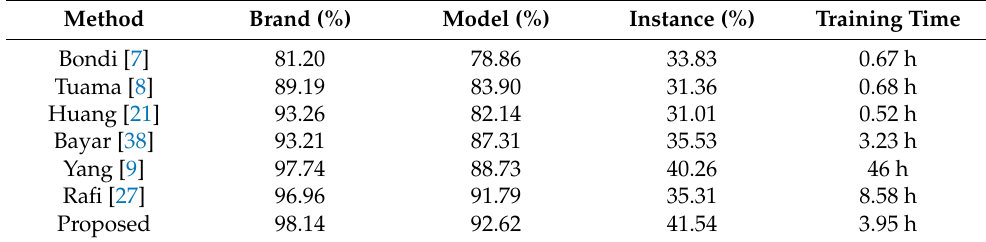
Table 6. SCI accuracy comparison with state-of-the-art methods at three levels.